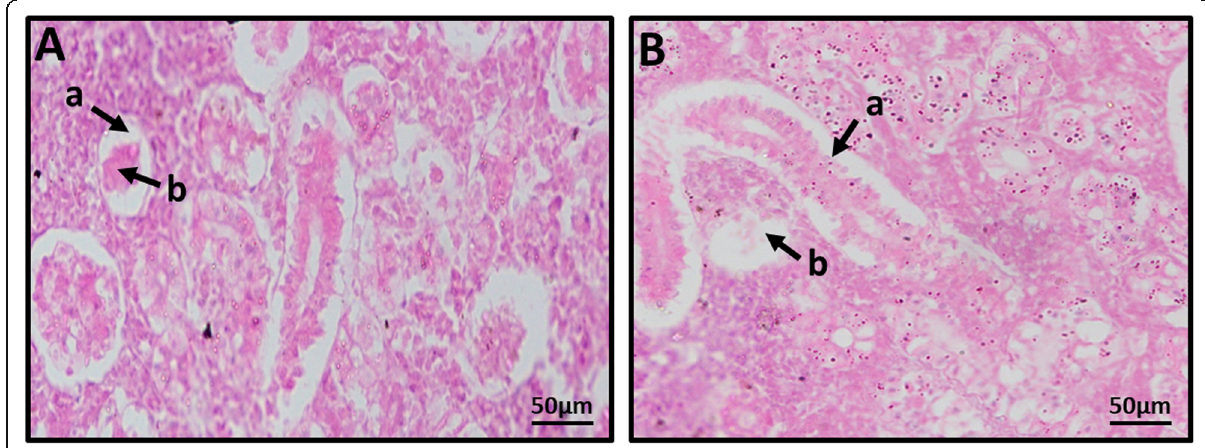
Fig. 7 Photomicrographs of kidney of Heteropneustes fossilis after 7-day exposure to 0.0075 ppm Envoy 50 SC. Severe ( a ) glomerular expansion (a) and cellular degeneration (b) and ( b ) increasing the diameter of renal tubule (a) and vacuolation (b) were observed